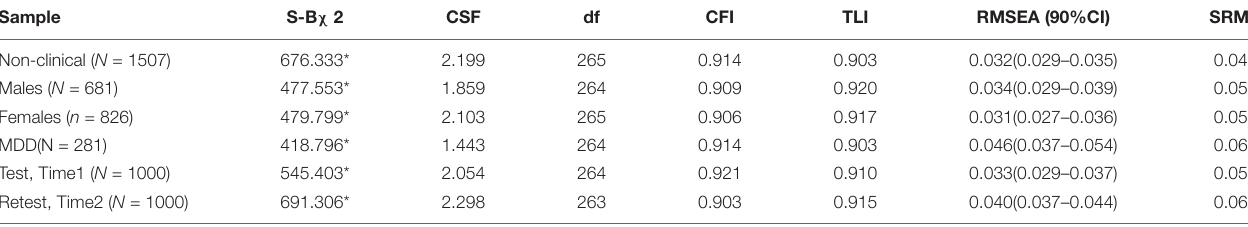
TABLE 9 | Fit indices summary for the five-factor CTQ-SF model. Sample